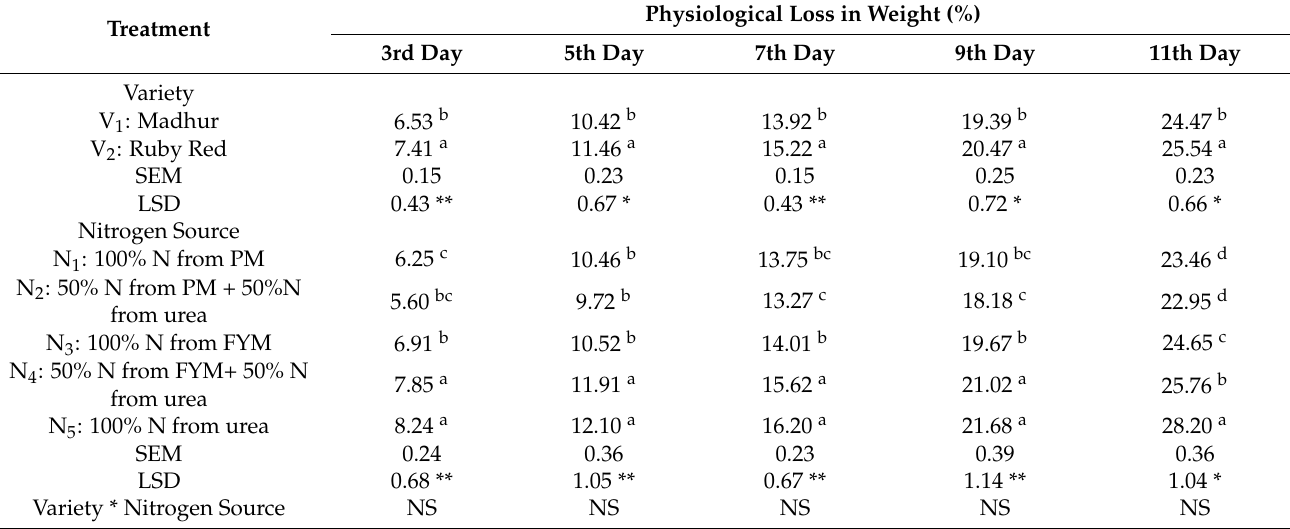
Table 10. Effect of variety and nitrogen source on physiological weight loss (%) of beetroot at different days of storage at AFU, Rampur, Chitwan in 2018/19.